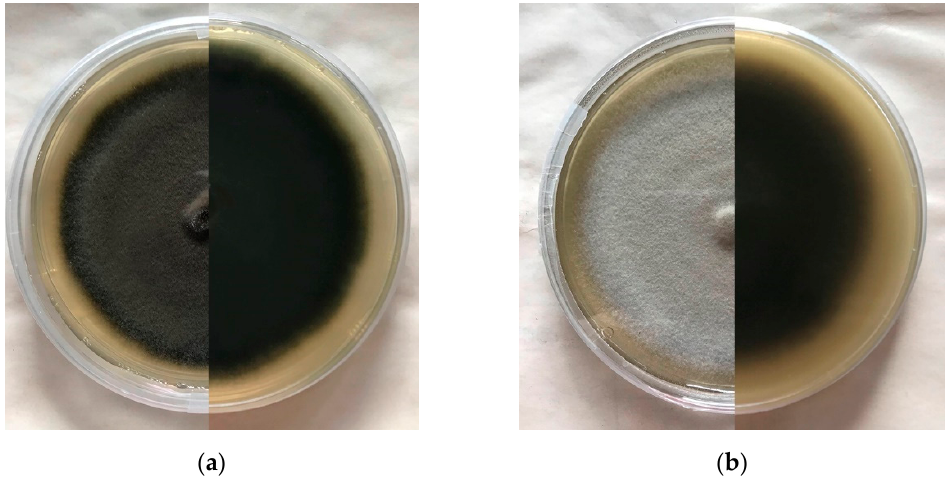
Figure 1. Upper and reverse perspectives of Esteya spp. cultured on PDA: ( a ) E. vermicola CNU 120806; ( b ) E. floridanum 14639.